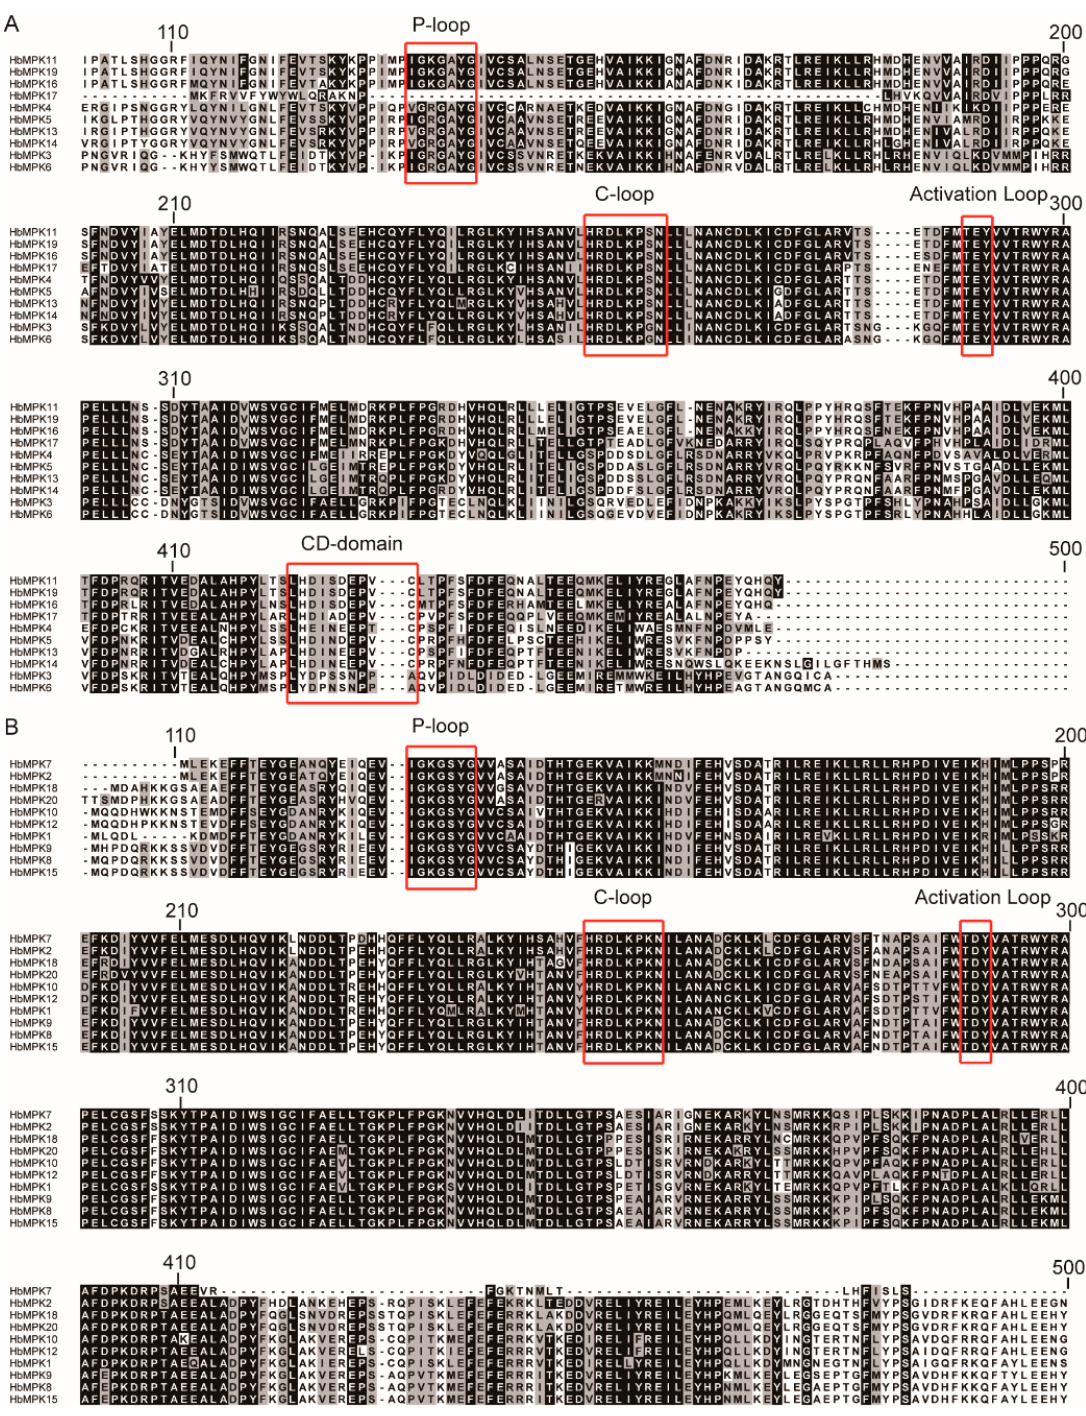
Figure 3. Multiple sequence alignment of the MPK proteins in Hevea . Conserved regions are shadowed. ( A ) Ten HbMPK members that contain a Thr-Glu-Tyr (TEY) activation site and a CD-domain; ( B ) Ten HbMPK members that contain a Thr-Asp-Tyr (TDY) active site. The alignment regions range from amino acids 100 to 500; each line consists of 100 amino acids. The four conserved domains (P-loop, C-loop, activation loop and CD-domain) are marked in red boxes.